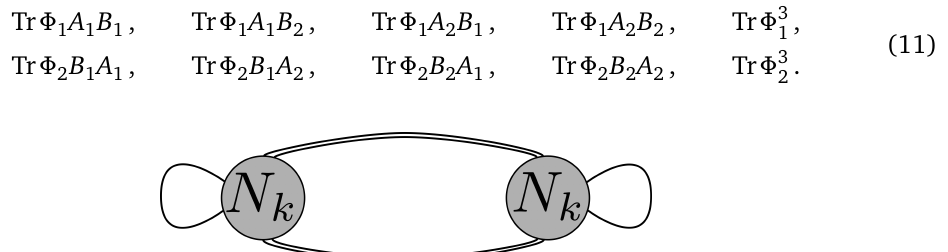
Figure 2: Quiver representation of the 4 d Z interpreted as a 3d N = 2 quiver with equal Chern-Simons